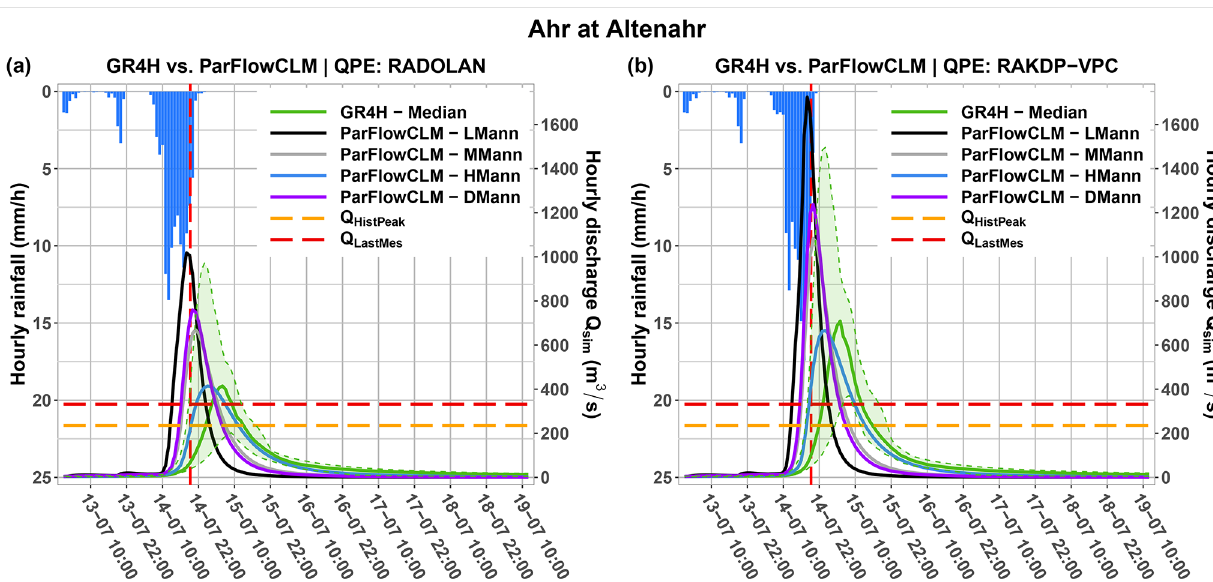
Figure 5. Simulated hydrographs by GR4H (in green) and ParFlowCLM (with low Manning’s coefficient LMann in black, medium Man- ning’s MMann coefficient in grey, high Manning’s HMann coefficient in blue, and distributed Manning’s coefficient DMann in violet) using (a) RADOLAN and (b) RAKDP-VPC as precipitation input for the Ahr at Altenahr. The green shaded area is delimited by the minimum and maximum values of estimated discharge by GR4H for each time step. The dashed orange line indicates the highest measured peak flow before July 2021. The dashed horizontal red line indicates the last measured flow before measurement devices became unavailable and the dashed vertical red line its